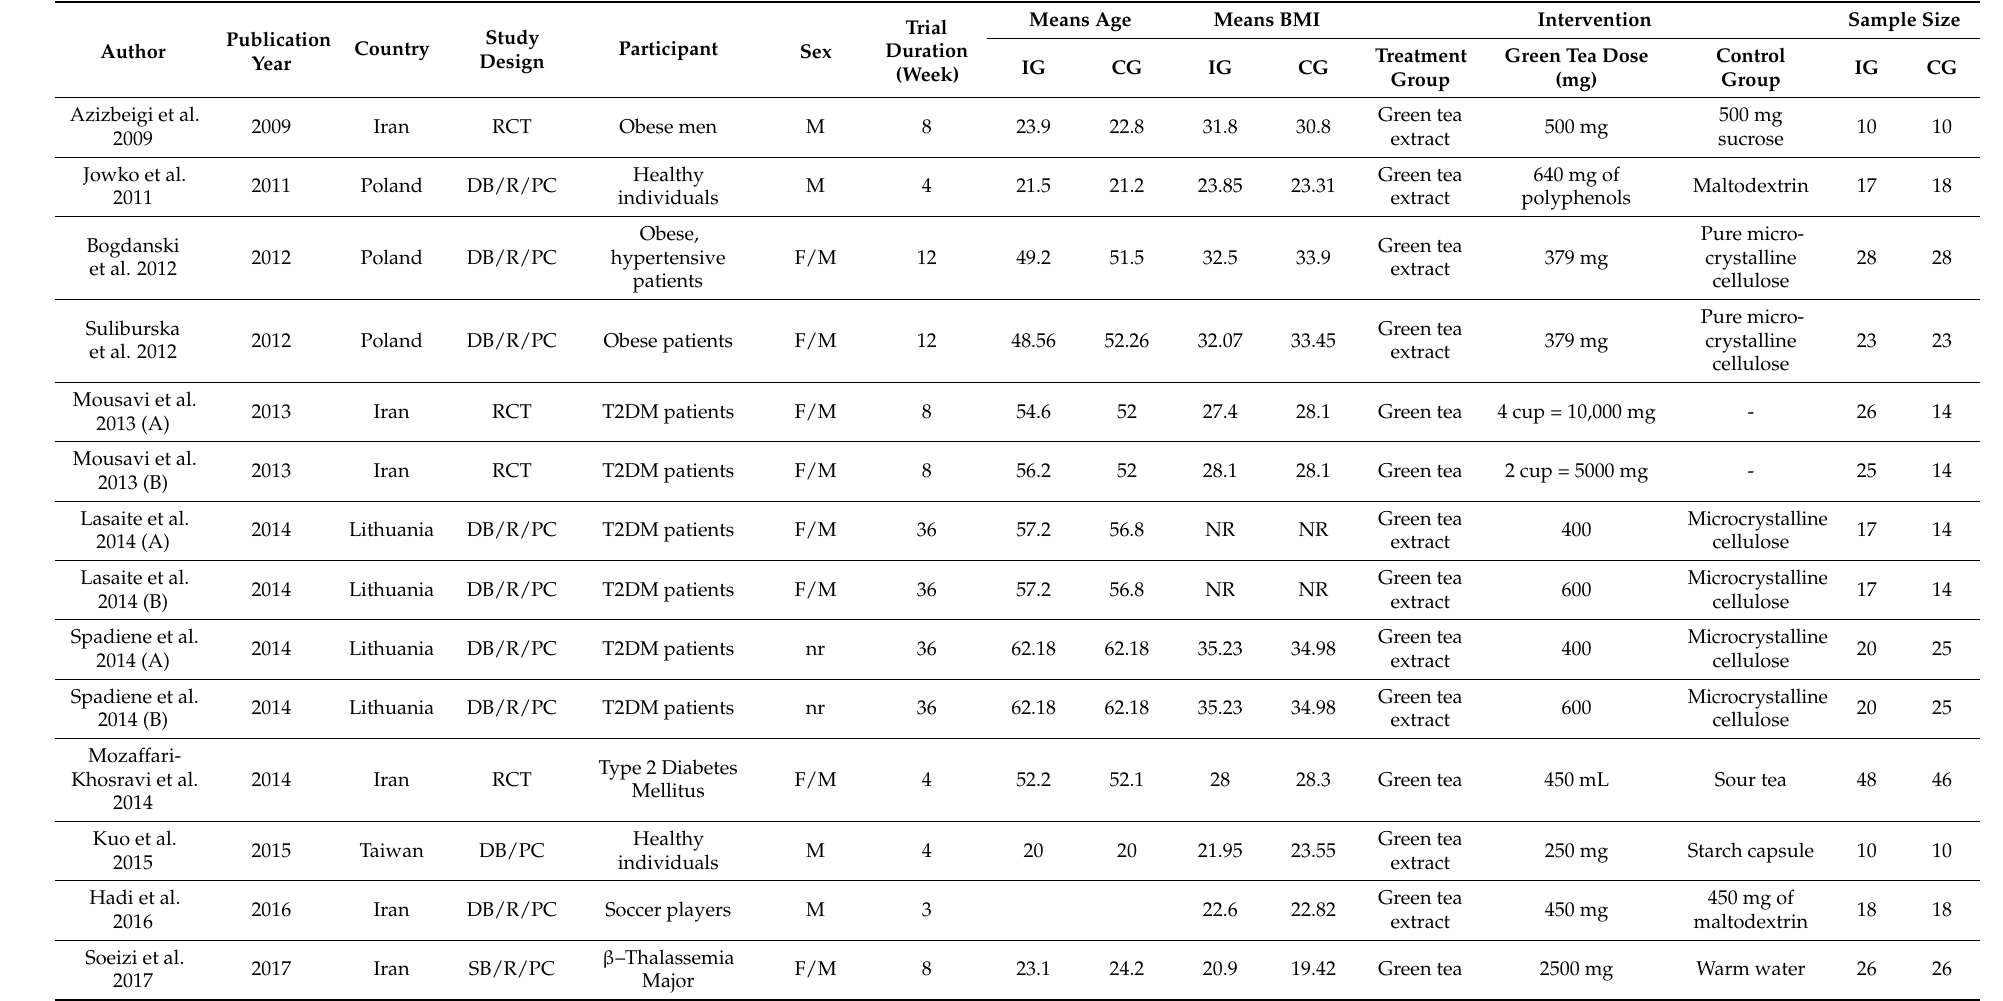
Table 1. Characteristic of included studies in